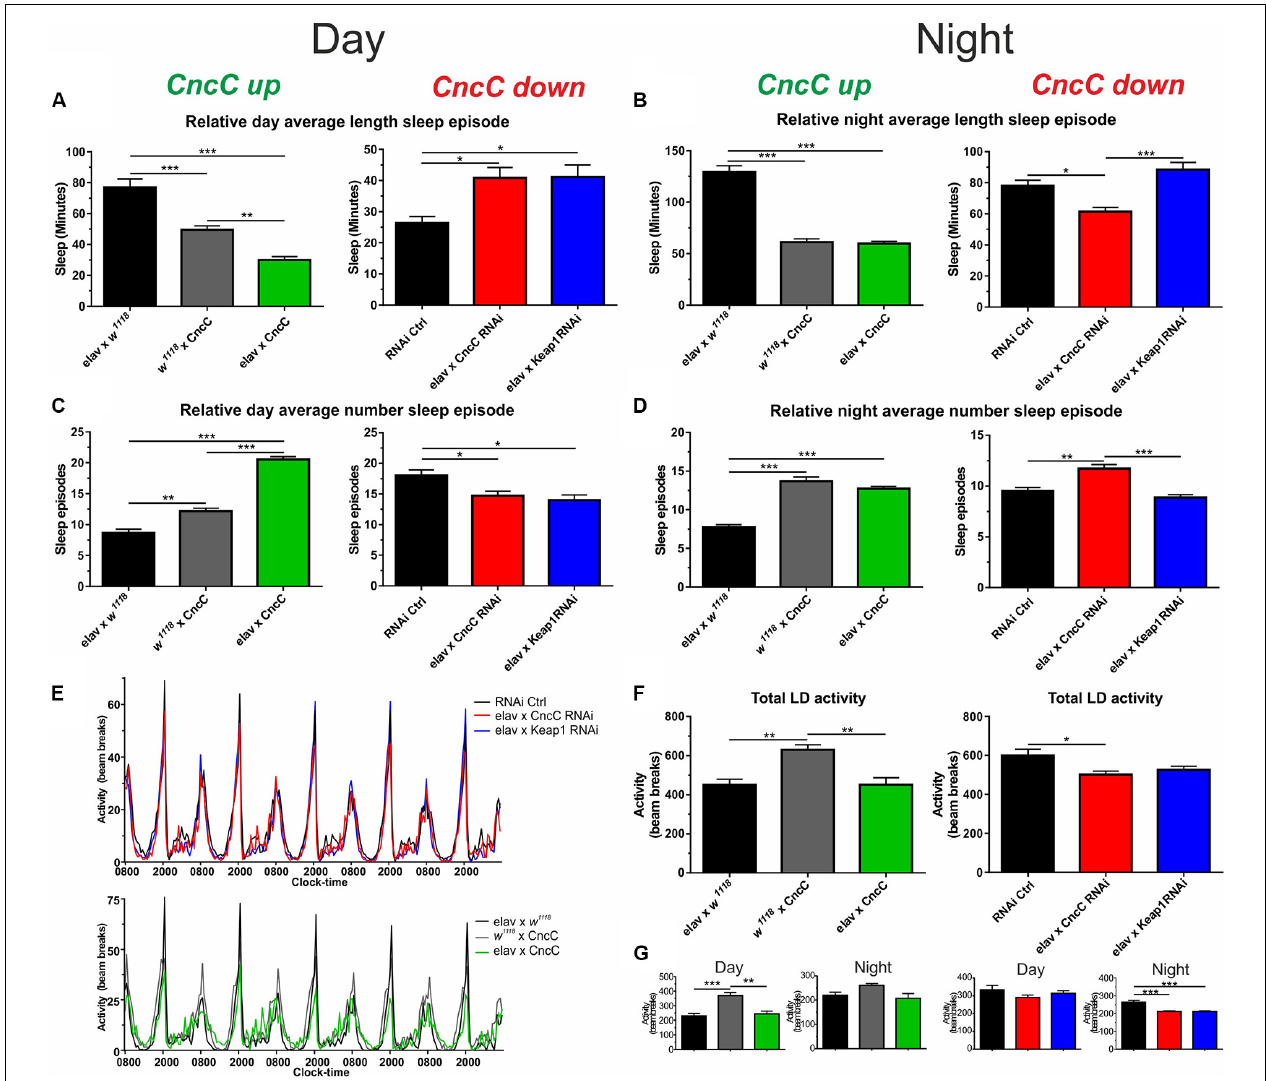
FIGURE 5 | The CncC/Keap1 signaling impacts on sleep and activity patterns. (A,B) Sleep duration (in min) was reduced following CncC OE and enhanced in CncC knock-down (KD) flies in the day time, during the night, CncC KD reduced sleep length. The overexpression of CncC caused fragmented sleep patterns in the day resulting in more but shorter sleep episodes in the night time (B) , whereas CncC KD reduces sleep length with more episodes in the night; (C,D) Keap1 silencing reverses the CncC KD effect in the night but not in the day. (D) During the night, both CncC OE and KD induce similar changes resulting in more but shorter